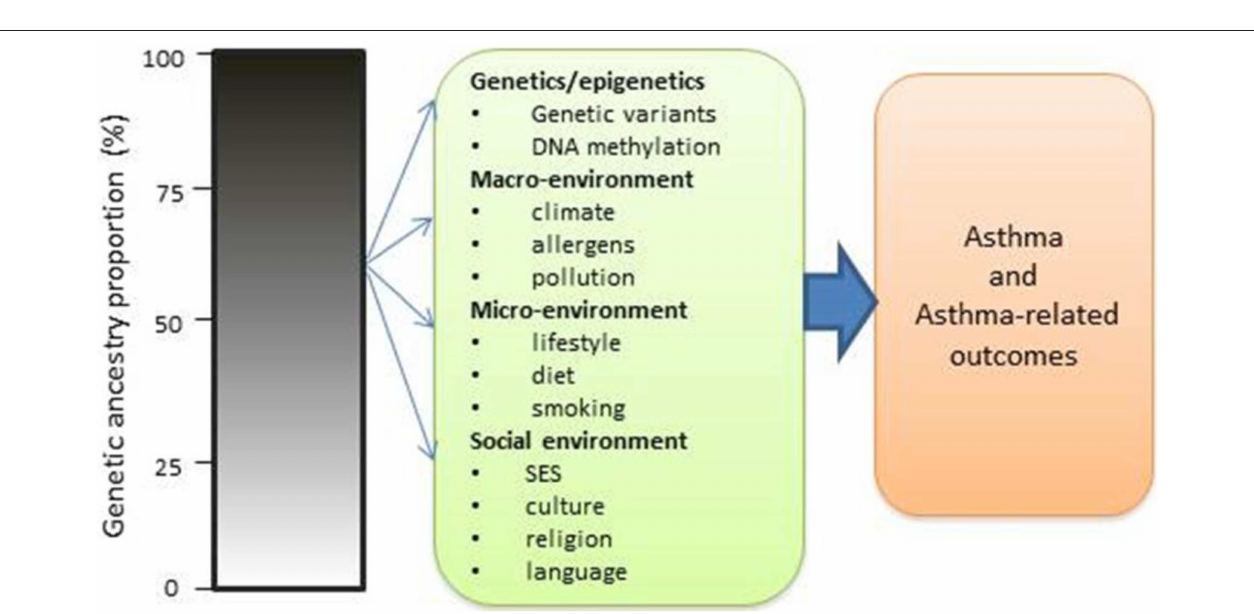
Frontiers in Genetics |